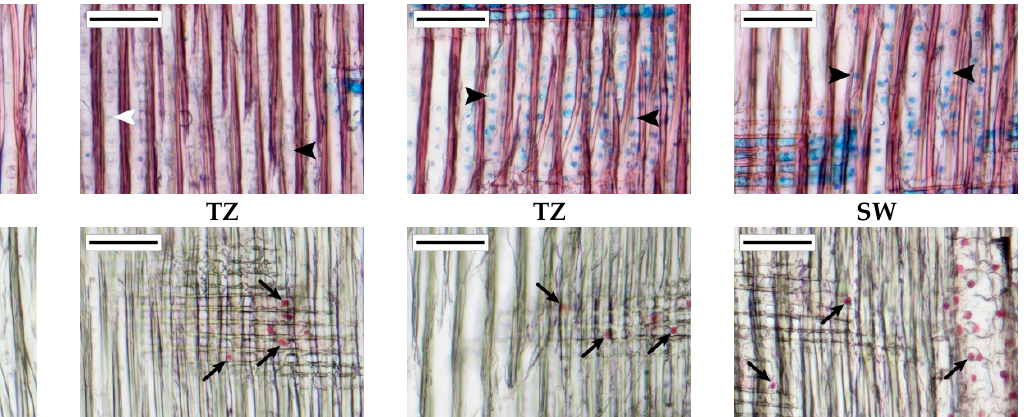
Figure 4. Representative images of four consecutive tree rings of a core sampled at the height of 1.5 m from the model tree in SP 8, Lichen pine forest, 70–80 years. HW—heartwood, TZ—transition zone, SW—sapwood. Scale bar = 100 μ m. In the top row are images of radial sections treated with alcian blue and safranine. In the sapwood, alcian blue stains tori of the bordered pits in blue (black arrowheads). In the transition zone, the colour of tori changes from blue to pink (white arrowheads) because of extractives and lignin on the pit membranes. In the heartwood, all pit membranes are stained with safranine in pink. Images of radial sections treated with acetocarmine are in the bottom row. Most of the ray parenchyma cells in the sapwood have nuclei (black arrows). In the transition zone, there is a sharp death of parenchyma cells. As a result, nuclei are absent in the parenchyma cells located in the heartwood.